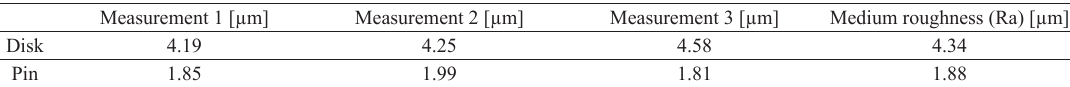
Table 1. Measurements and average values of disk and pin